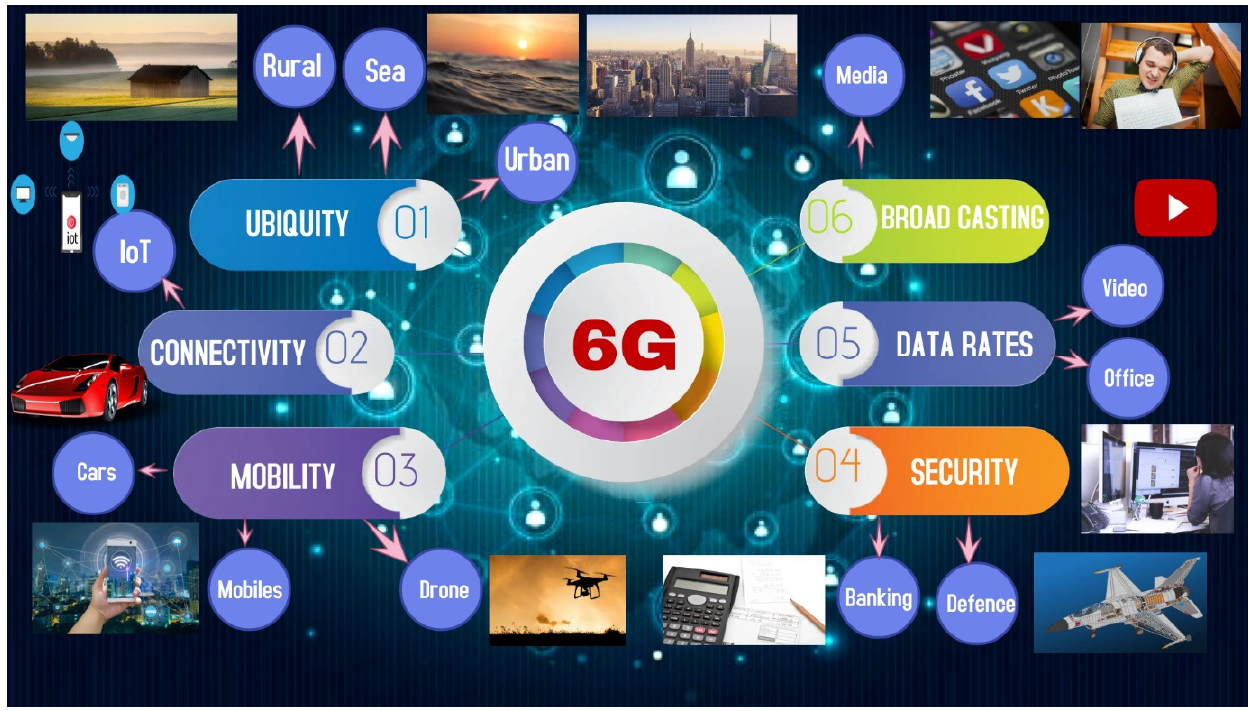
Figure 3. The key features of the 6G communication system.